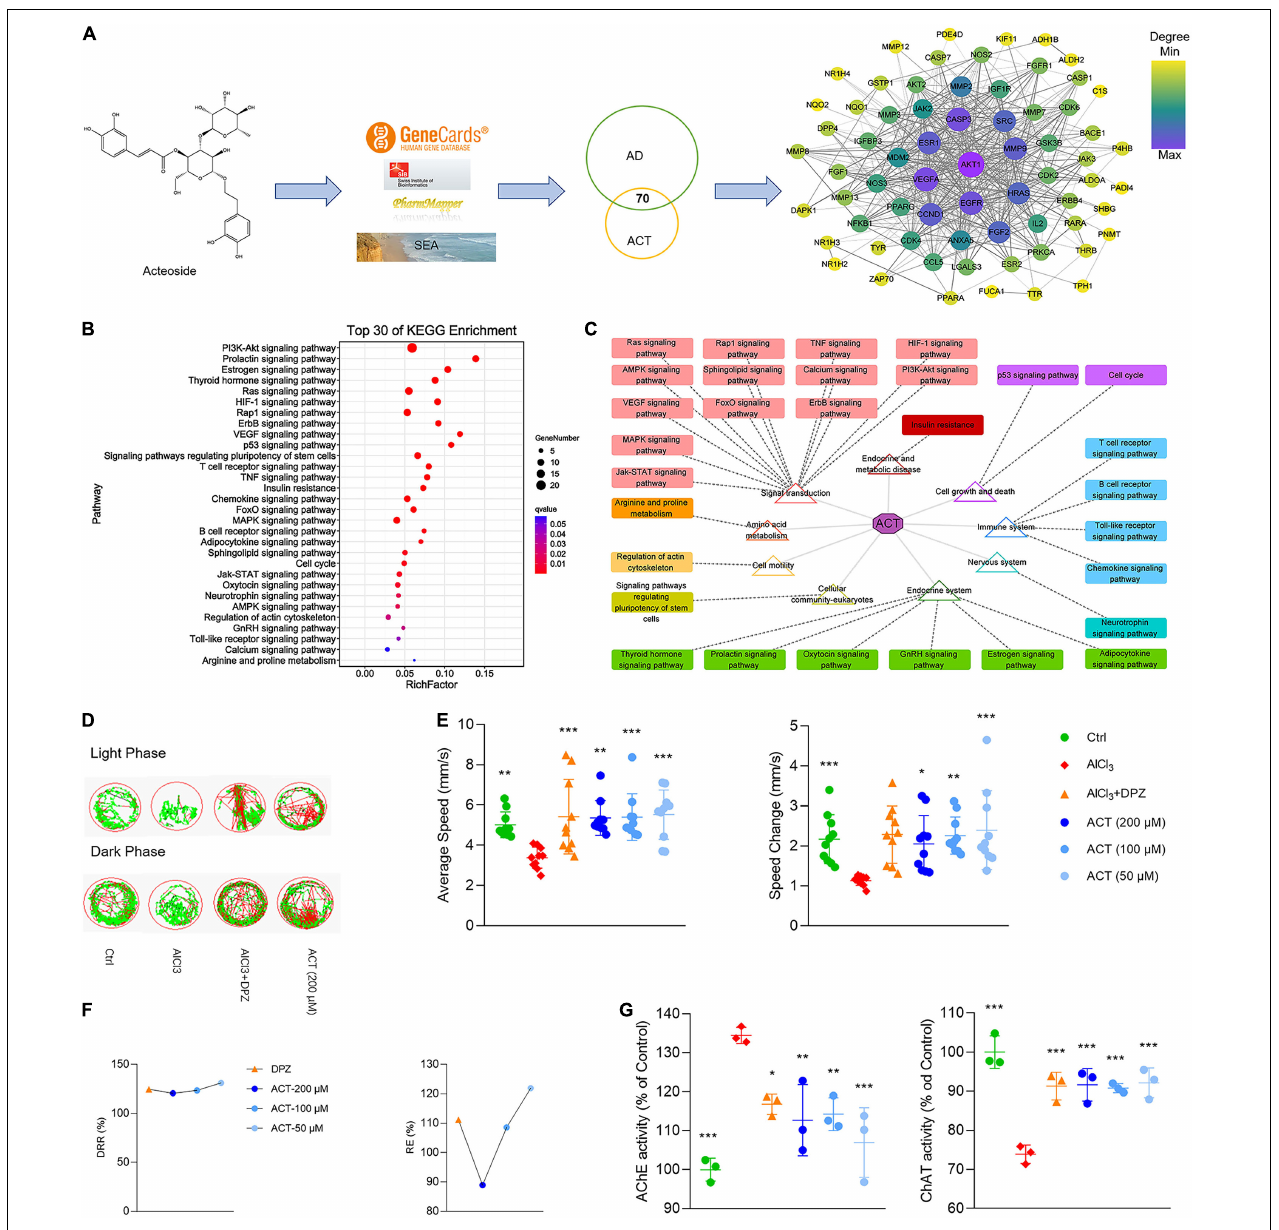
FIGURE 1 | ACT attenuated AlCl 3 -induced AD in zebrafish larvae. (A) The workflow of ACT-AD targets interaction network modeling. The size and color of nodes represented the degree of targets. The width of edges was consistent with the combined score of targets. (B) Top 30 of KEGG enrichment. (C) Illustration of KEGG pathway enrichment analysis. (D) The representative swimming trails of zebrafish larvae in the light and dark phase. (E) The average speed and speed change in different groups ( n = 10). (F) DRR (%) and RE (%) in the drug treatment groups ( n = 10). (G) The evaluation of AChE and ChAT activities ( n = 3). * P < 0.05, ** P < 0.01, and *** P < 0.005, versus the AlCl 3 group. DPZ as the positive